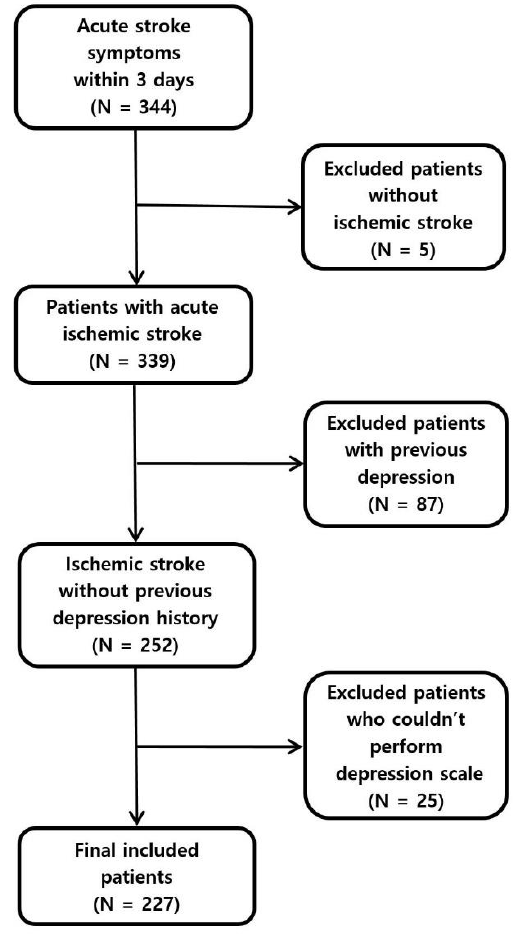
Figure 1. Flowchart of Patient Selection.